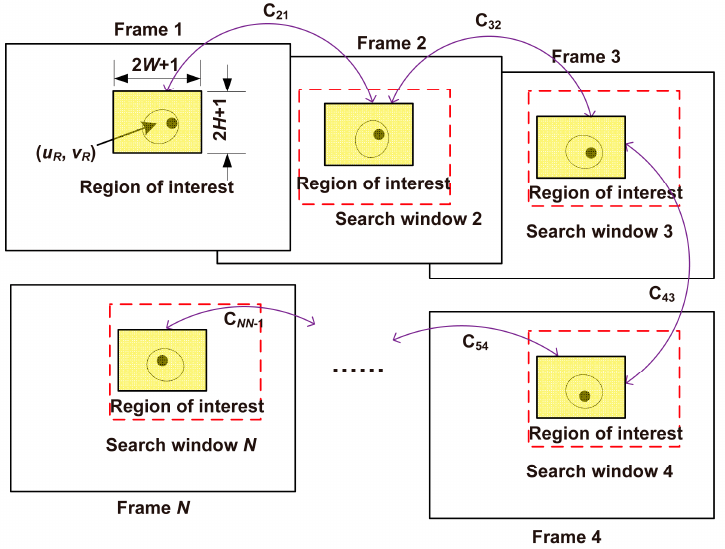
Figure 6. Schematic illustration of the selection of the reference frame. The rectangular regions surrounded by the red dashed lines show the search windows which were determined in Section 3.3.2. The yellow rectangular region in each frame shows the region of interest, whose center is denoted by ( u Ri , v Ri ), where i ∈ [ 1, N ].